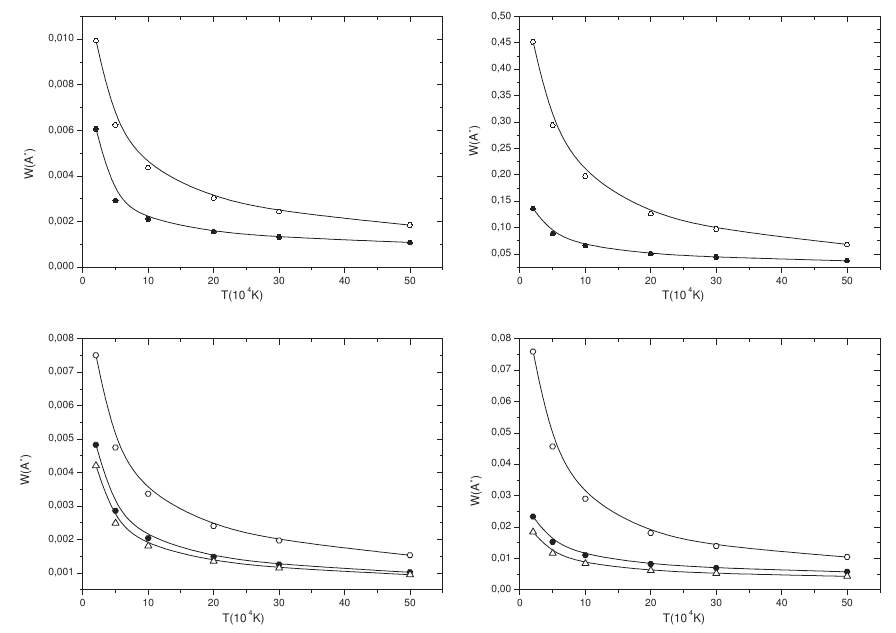
Figure 1. Ratios Q ( • ) and Strong ( ◦ ) as a function of the electron temperature for the transitions: SCP SST Total − 3s4d 3 D 3s3d 3 D 2 − 3s4p 3 P o ( left up ), 3s3p 3 P o 3 ( right up ), 3s4p 2 1 1 P o − 3s4s 1 S 0 ( right down ). 1